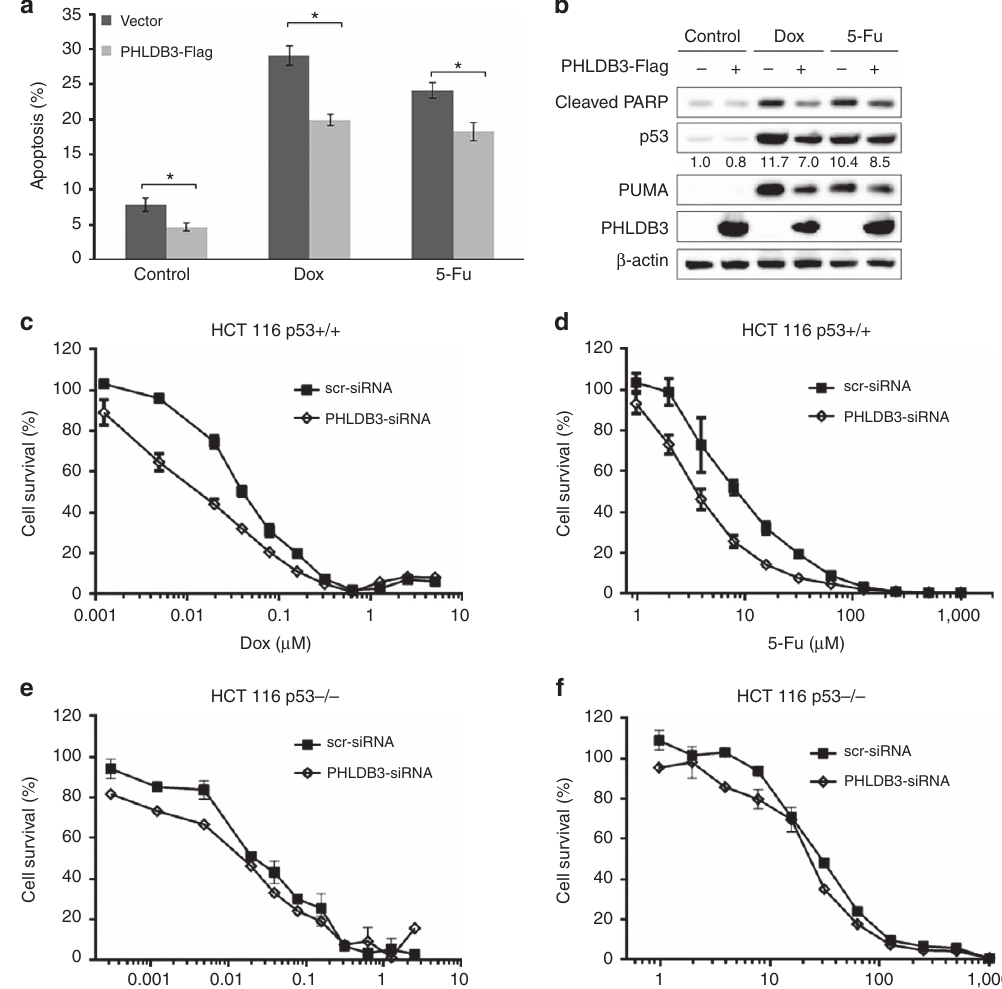
Figure 7 | PHLDB3 reduces the sensitivity of colorectal cancer cells to chemotherapeutic drugs. ( a , b ) the effect of PHLDB3 overexpression on apoptosis in HCT116 p53 þ / þ following drugs treatment. HCT116 p53 þ / þ cells were transfected with PHLDB3-Flag or vector plasmid and then treated with Dox or 5-Fu for 16h before harvesting. Cells were harvested 48h post-transfection for flow cytometry analysis ( a ) or immunoblotting with indicated antibodies ( b ). Quantification of Sub-G1 population is shown in a . Data represent mean ± s.e.m. of triplicate experiments.* P o 0.01 by two-tailed t-test. The relative quantification of p53 protein level is shown in b . ( c – f ) Knockdown of PHLDB3 causes more drastic suppression of cell viability in p53-containing cancer cells than in p53-null cancer cells. HCT116 p53 þ / þ ( c , d ) or HCT116 p53 (cid:2) / (cid:2) ( e , f ) cells were transfected with PHLDB3 or control siRNA, and seeded in 96-well plates next day. Dox or 5-Fu was supplemented for 72h before cell viability detection by